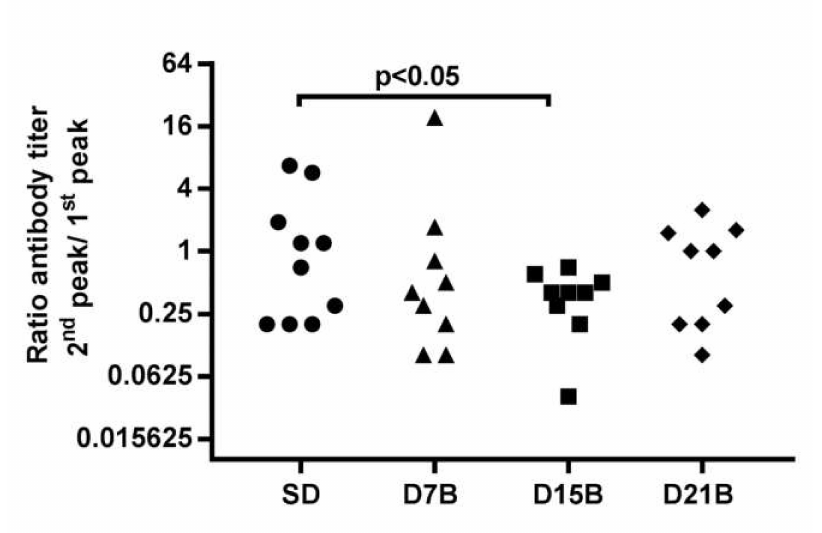
Figure 3. The dot plot shows the ratio between the magnitude of the peak of the secondary and primary anti-A β IgG response in individual mice from groups SD, D7B, D15B, and D21B. In this analysis, a high ratio indicates that the individual mounted a secondary response of greater magnitude than the primary response, which is the operative definition of immunological recall memory. In the D15B group that received a booster dose at day 15, the ratio between the magnitude of the peak of the secondary and primary IgG is significantly reduced ( p < 0.05, t test) compared to the control group, indicating that the day 15 dose impaired the development of immunological